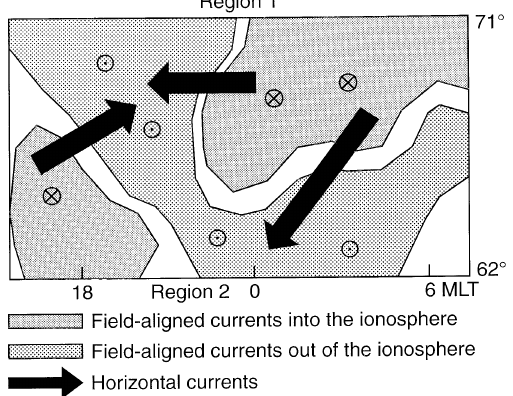
Fig. 9. Sketch of the current system on the nightside of the auroral ionosphere (note that there is no arrow pointing between the two current sheets of region